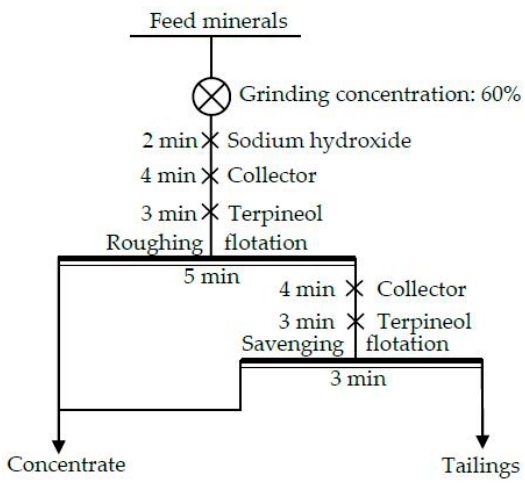
Figure 1. Chart of the single factor condition test.